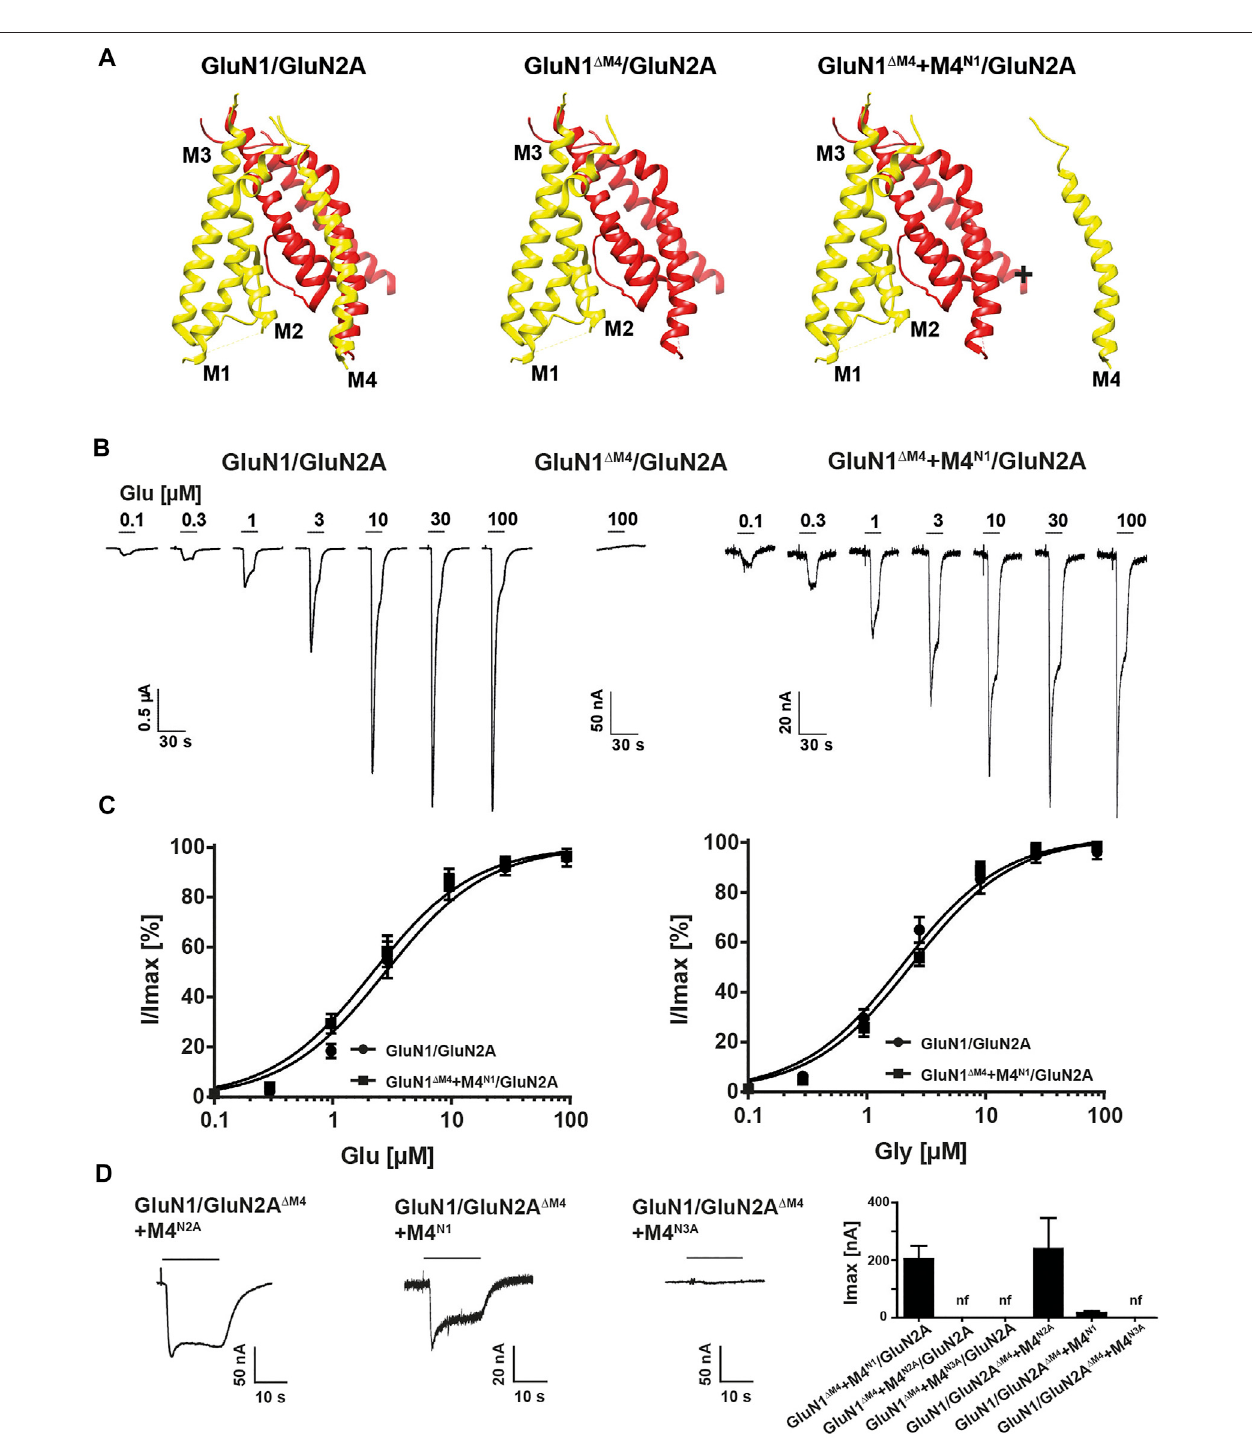
FIGURE 1 | Functional characterization of M4-deleted and M4-co-expressed GluN1/GluN2A NMDA receptors. (A) Structure of the TMD region of a GluN1 (yellow)/GluN2A (red) NMDARshowingtheperipherallocalizationoftheM4comparedtoM1,M2andM3ofitsownsubunit.StructureinthemiddleandrightshowtheM4-truncatedreceptor(GluN1 Δ M4 /GluN2A) and exemplary M4-truncated receptor with the separate M4 segment (GluN1 Δ M4 +M4 N1 /GluN2A). Structural analysis was performed from PDB 5UP2 using UCSF Chimera. (B) Agonist responsepropertiesofwtGluN1/GluN2Areceptor(left),nonfunctionaltruncatedGluN1 Δ M4 /GluN2A(middle),andGluN1 Δ M4 +M4 N1 /GluN2Areceptor(right)rescuedbyM4segmentco- expressionrecordedbysuperfusionofincreasingconcentrationsofglutamateinthepresenceofglycine2 – 3 daysafterinjection. (C) GlutamateorglycinedoseresponsecurvesforwtGluN1/ GluN2A and GluN1 Δ M4 +M4 N1 /GluN2A NMDARs in the presence of glycine (left) or in the presence of glutamate (right). Data represent mean ± SEM values. (D) Representative TEVC recordings of GluN1/GluN2A Δ M4 +M4 N2A (left) and GluN1/GluN2A Δ M4 +M4 N1 (middle) show rescued functionality of GluN2A-M4 truncated receptors with M4 N1 or M4 N2A . No measurable currentscouldbeobtainedforGluN1/GluN2A Δ M4 +M4 N3A (right),highlightingthedifferencesbetweentheM4segmentsofGluN1,GluN2A,andGluN3A.RightpanelshowsI max currentsof co-expression of M4-deleted GluN1/GluN2A NMDARs in the presence of M4 fragments ( n (cid:1) 5 – 12). Data represent mean values ± SEM.